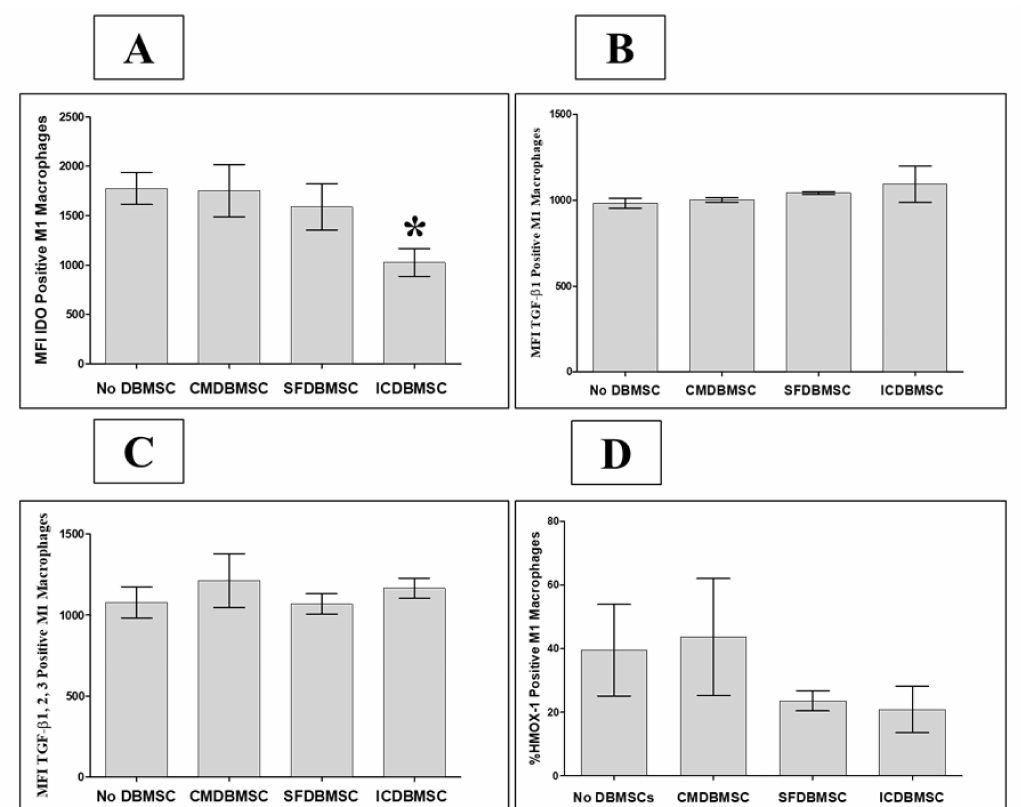
Figure 6. Effects of human DBMSCs on expression of the intracellular molecules IDO, TGF β 1, TGF β 1, 2, 3, and HMOX-1 by human monocytes differentiated into macrophages by GM-CSF, as analyzed by flow cytometry. After six days in culture, compared to untreated macrophages, CMDBMSCs, and SFDBMSCs had no significant effects ( p > 0.05) on expression of IDO ( A ), TGF β 1 ( B ), TGF β 1, 2, 3 ( C ), and HMOX-1 ( D ) by macrophages. In addition, after six days in culture, compared to